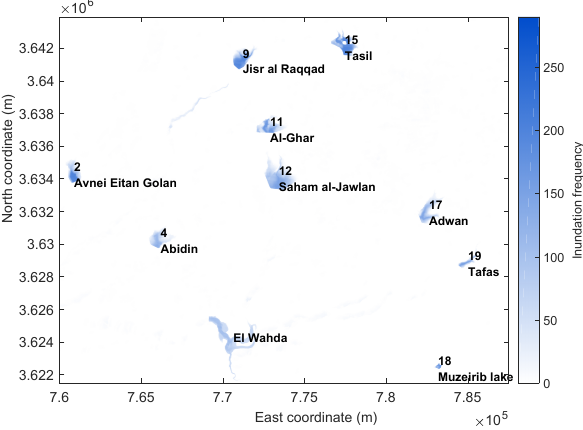
Figure 3. Image of the number of times each pixel has been cov- ered by water ( M occ ). The text in black indicates the identification number (for Syrian reservoirs) and the name of known reservoirs. Coordinates are expressed in CRS WGS 84/UTM zone